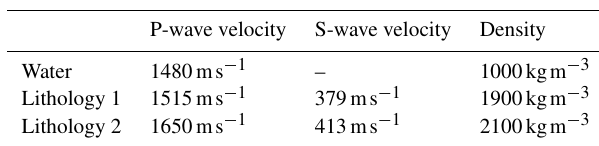
Table 1. Elastic parameters for the water layer and the two compo- nent sediment